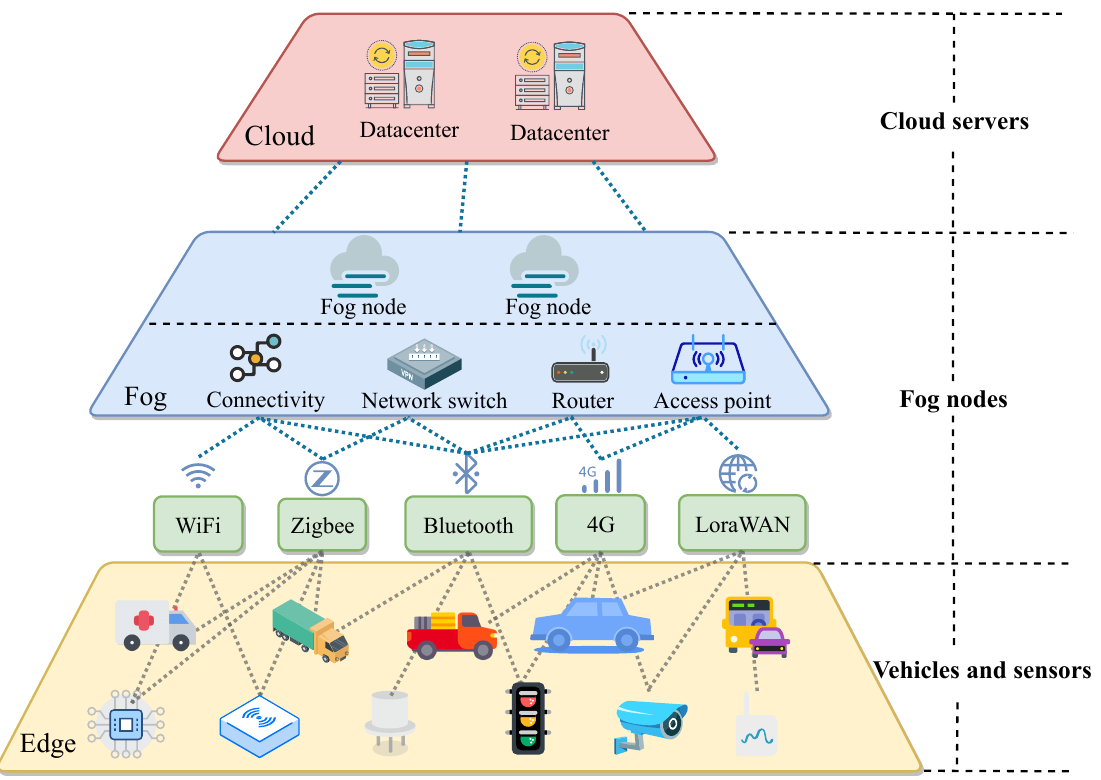
Figure 1. Holistic view of Edge–Fog–Cloud interplay framework for intelligent